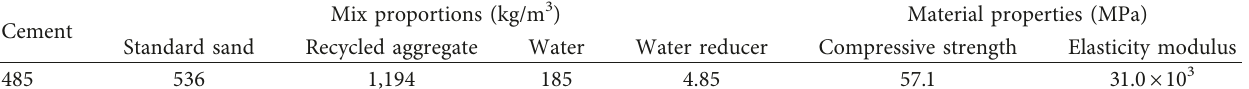
Table 2: Mix design and material properties of